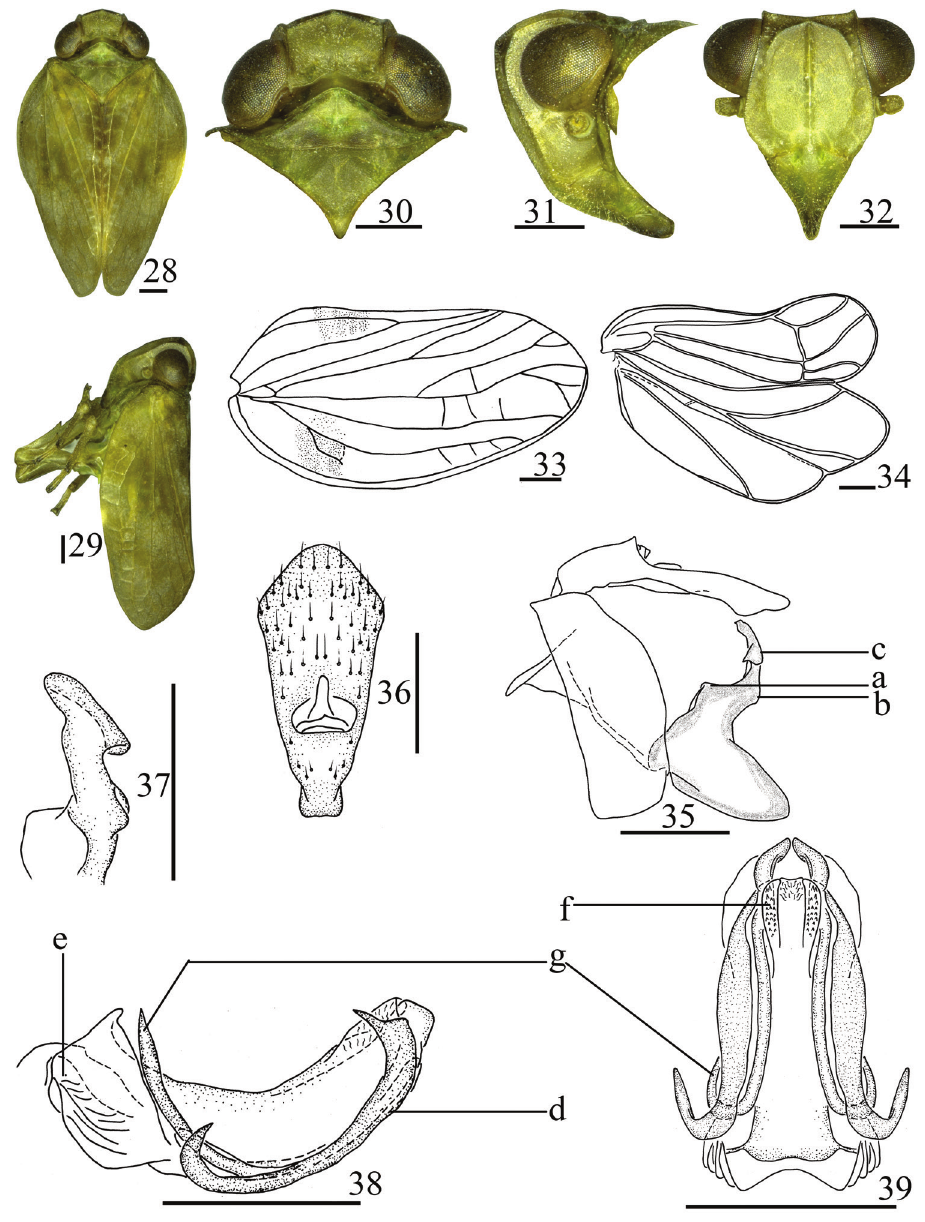
Figures 28–39. Tetrichina trihamulata Chang & Chen, sp. nov. 28 adult, dorsal view 29 same, lateral view 30 head and thorax, dorsal view 31 same, lateral view 32 head, ventral view 33 forewing 34 hindwing 35 male genitalia, lateral view 36 male anal segment, dorsal view 37 capitulum of genital styles, posterior view 38 aedeagus and phallobase, lateral view 39 same, ventral view. Scale bars: 0.5 mm.